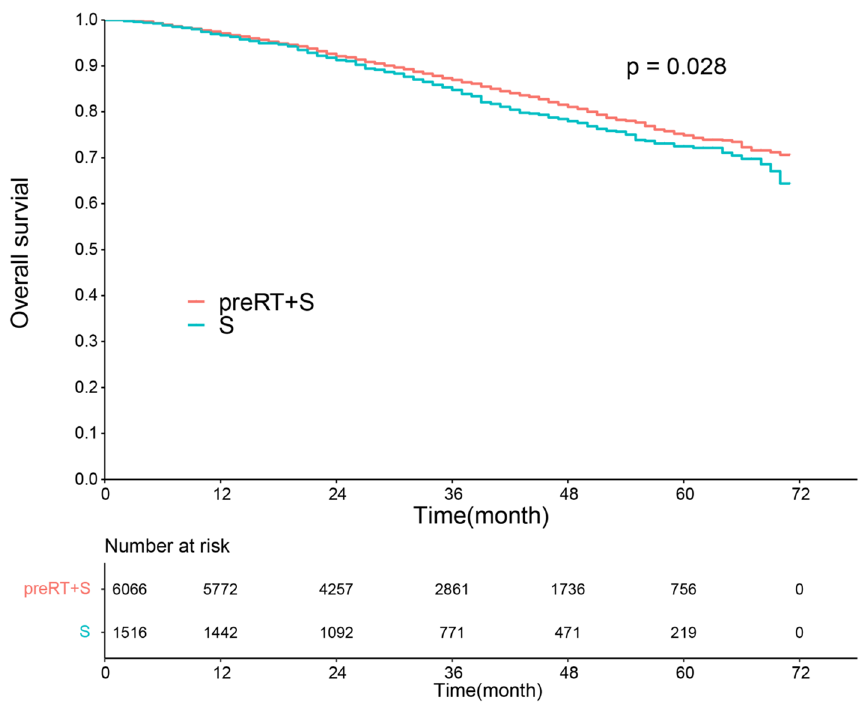
Figure 1. Kaplan–Meier analysis of overall survival according to preoperative radiotherapy (preRT). S